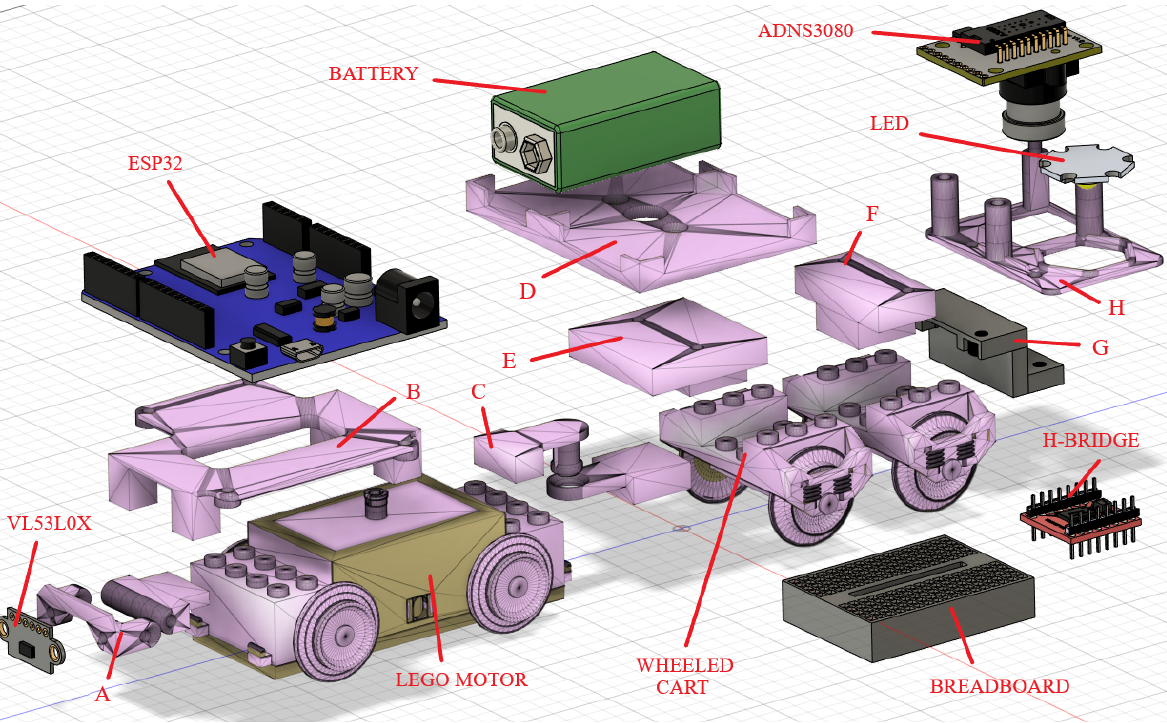
Figure 8. Disassembled PL-toon